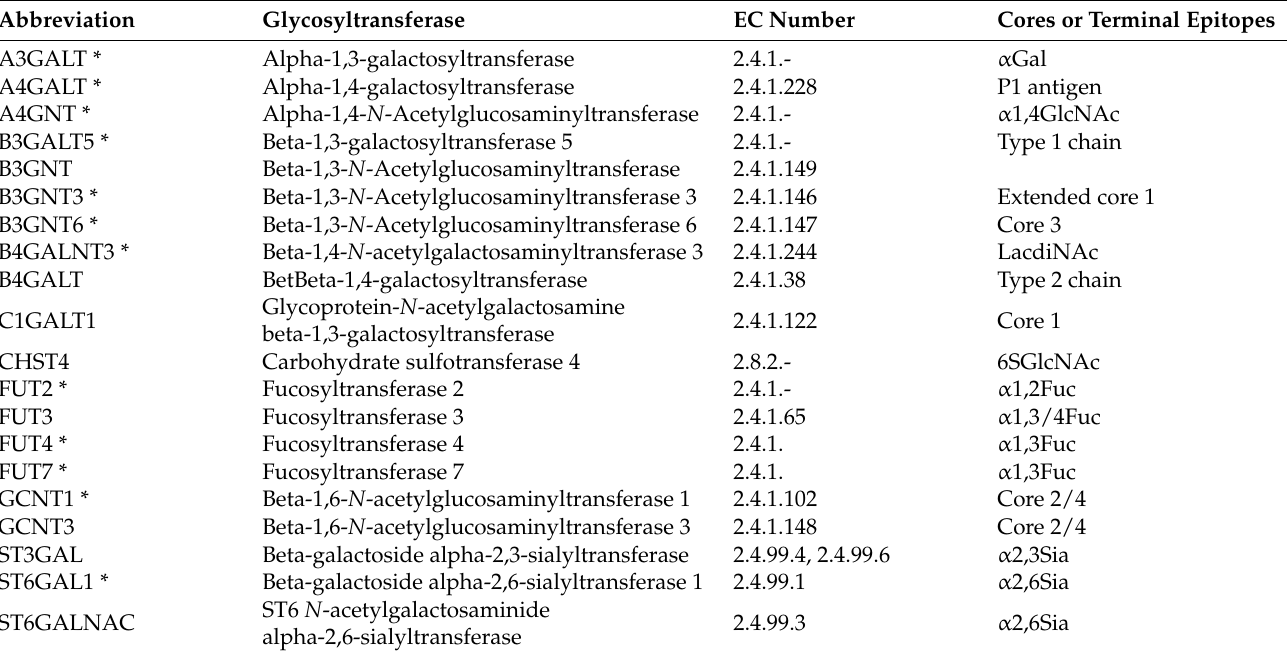
Table 2. Glycosyltransferases used in CHO O -glycan profile